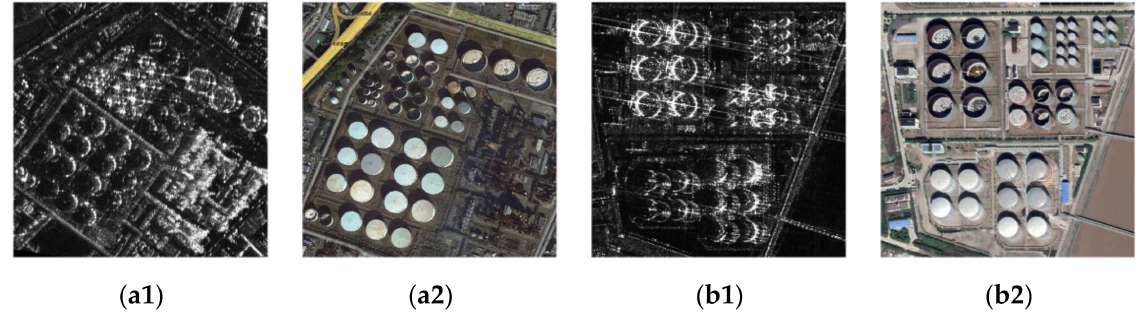
Figure 3. The appearance of a single oil tank with a fixed roof. ( a1 ) An optical image from Google Earth, ( a2 ) an SAR image acquired with the GF-3 SL mode showing the strong scattering centers A1, A2, and B1, and ( a3 ) the SAR geometric imaging mode of the tank. The appearance of a single oil tank with a floating roof ( b1 ) An optical image from Google Earth, ( b2 ) an SAR image acquired with the GF-3 SL mode showing the strong scattering centers A1, A2, B1, and B2, and ( b3 ) the SAR geometric imaging mode of the tank.